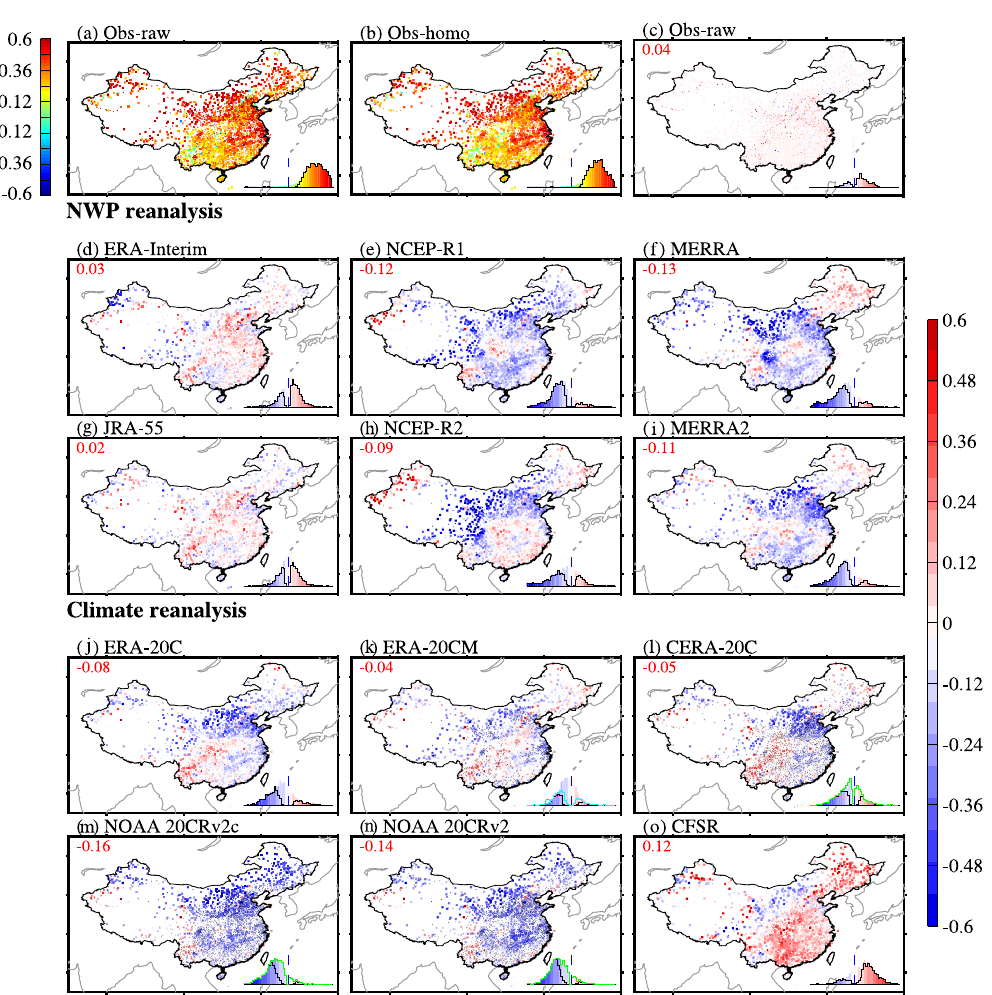
Figure 5. (a, b) The observed trends in surface air temperature ( T a , unit: ◦ Cdecade − 1 ) and the simulated biases in the trends in T a (unit: ◦ Cdecade − 1 ) during the period of 1979–2010 from (c) raw observations and (d–o) the 12 reanalysis products over China with respect to the homogenized observations. The squares denote the original homogeneous time series, and the dots denote the adjusted homogeneous time series. The probability distribution functions of all of the biases in the trends are shown as coloured histograms, and the black stairs are integrated from the trend biases with a significance level of 0.05 (based on two-tailed Student’s t tests). The cyan and green stars in (k–n) represent estimates of the biases in the trends outside the ensemble ranges whose locations are denoted by the black dots shown in (k–n)